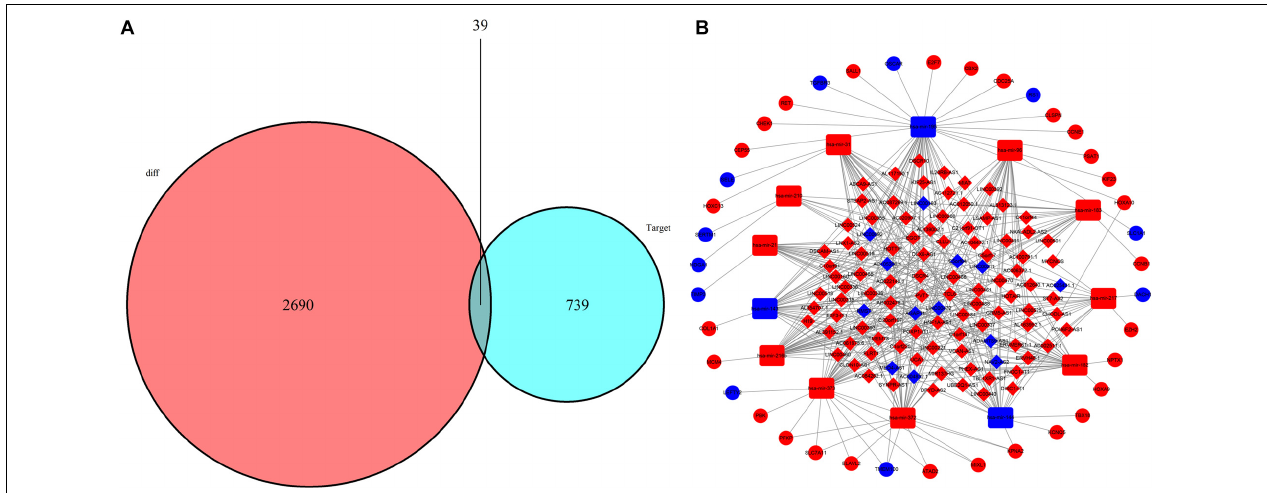
FIGURE 4 | Construction of lncRNA-miRNA-mRNA network in LUAD. (A) Venn diagram of mRNAs included in the ceRNA network; the red area represents the number of DEmRNAs; the blue area shows the number of DEmRNAs targeted by DEmiRNAs. The purple area in the middle indicates the number of DEmRNAs included in ceRNA network. (B) lncRNA-miRNA-mRNA ceRNA network in LUAD. Red nodes indicate up-regulated RNAs while blue nodes indicate down-regulated RNAs. Diamond, round rectangle and ball represent DElncRNAs, DEmiRNAs, and DEmRNAs, respectively.